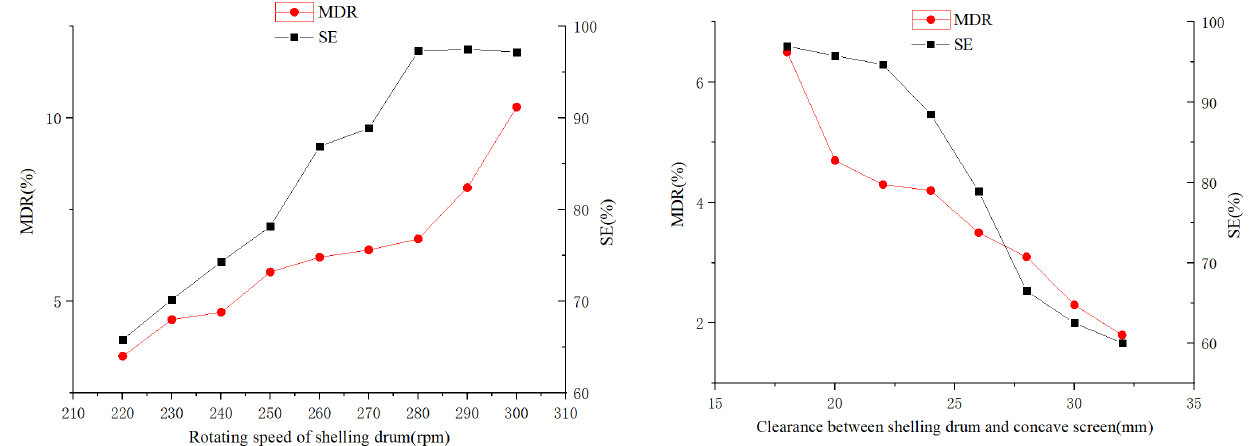
Figure 6. Effects of the single factor on MDR and SE.